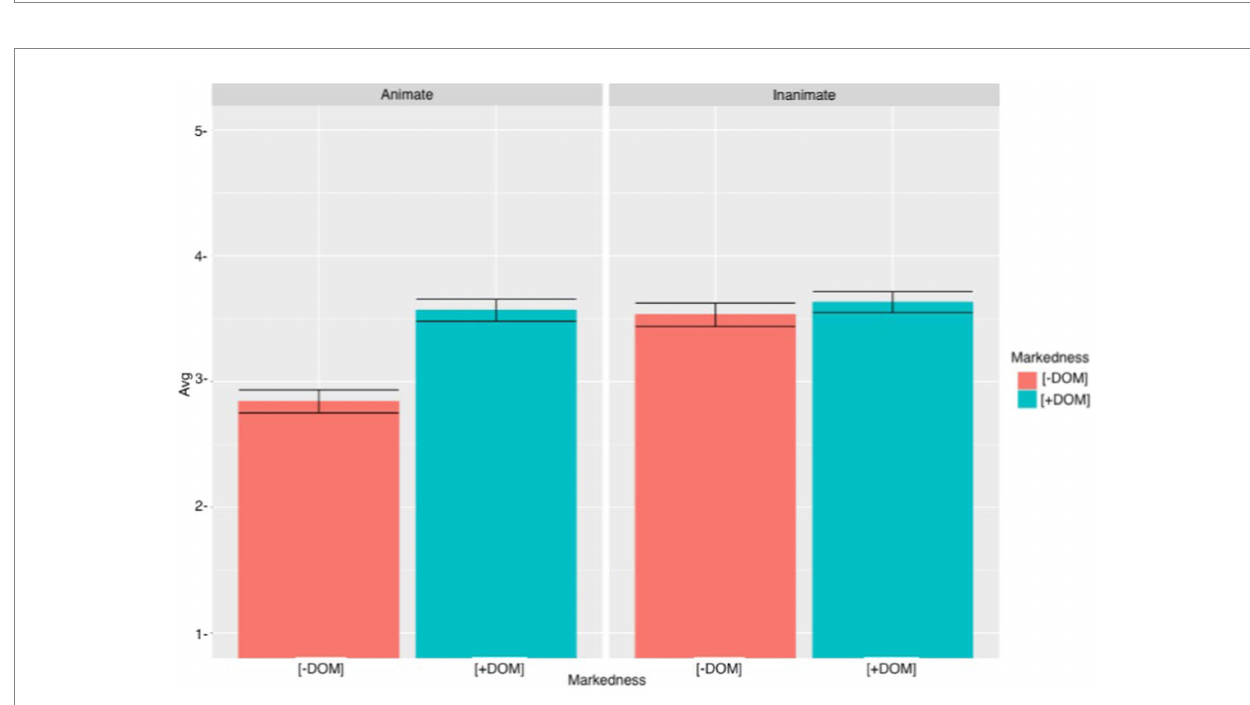
FIGURE 8 L2 learners’ mean acceptability scores and errors bars (95% CI) for VSO